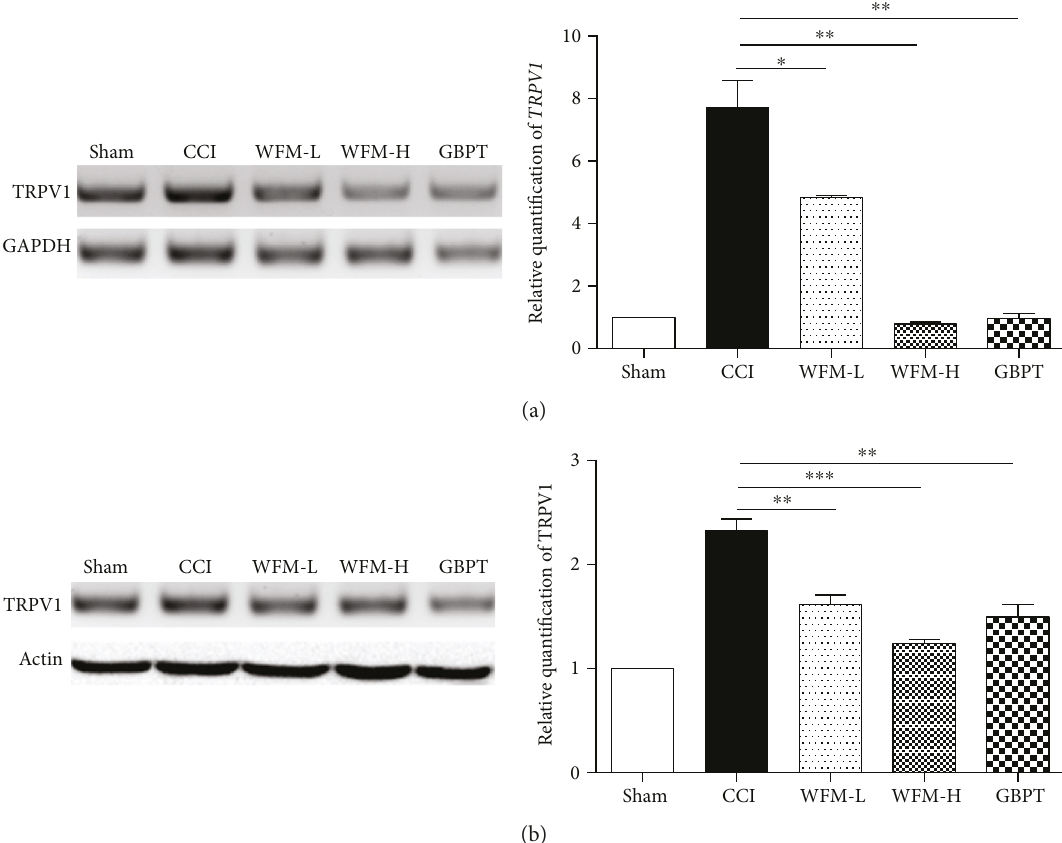
Figure 5: TRPV1 expression is signi fi cantly decreased in the DRG after WFM treatment. (a) Real-time PCR results indicate that TRPV1 expression is decreased after WFM treatment. (b) Western blot results con fi rm that TRPV1 expression is decreased after WFM treatment. ∗ p < 0 05 , ∗∗ p < 0 01 , ∗∗∗ p < 0 001